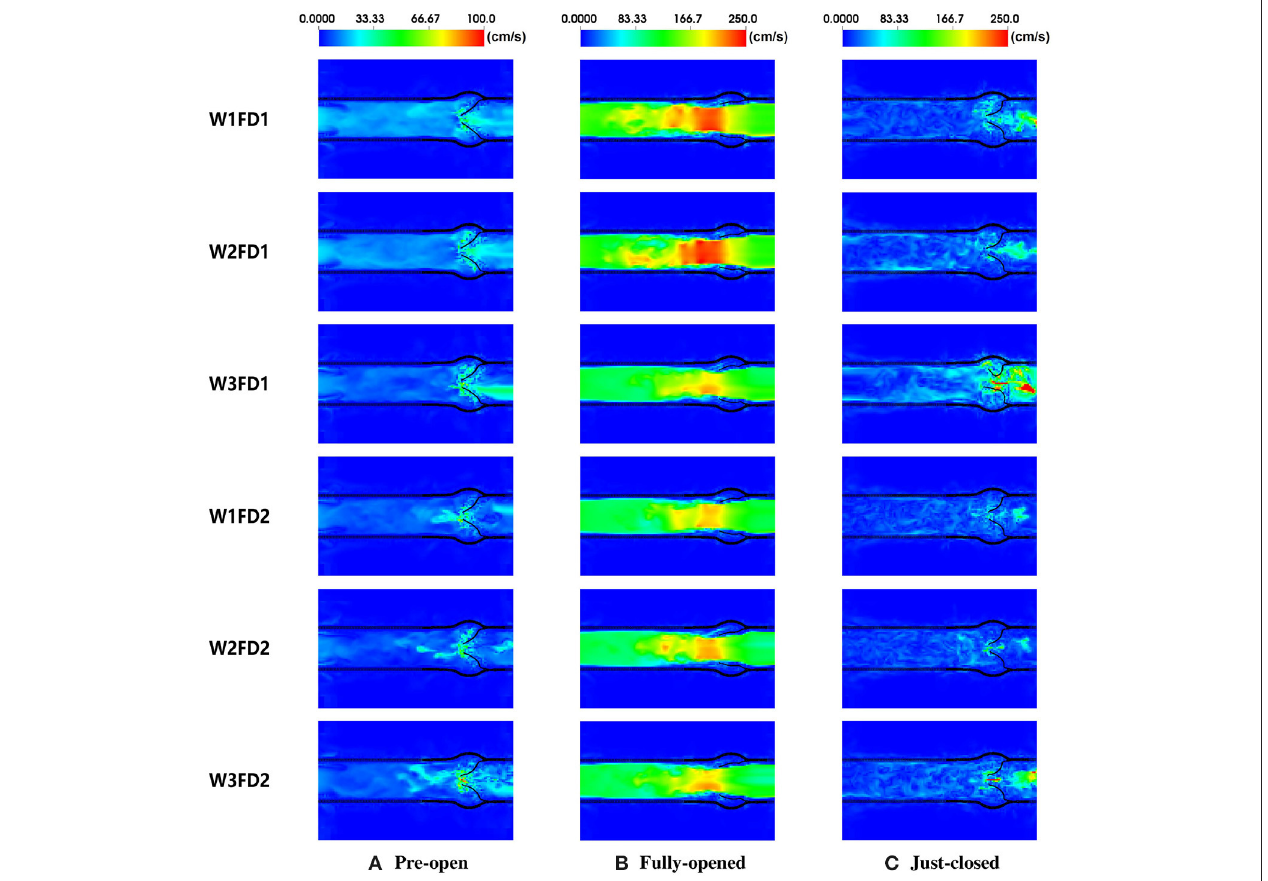
FIGURE 7 | The fluid velocity field of the AV with six different cases. The time points from left to right are 0.09, 0.18, and 0.41s, corresponding to (A) pre-open state, (B) fully opened state, and (C) just-closed state during the second cardiac cycle.